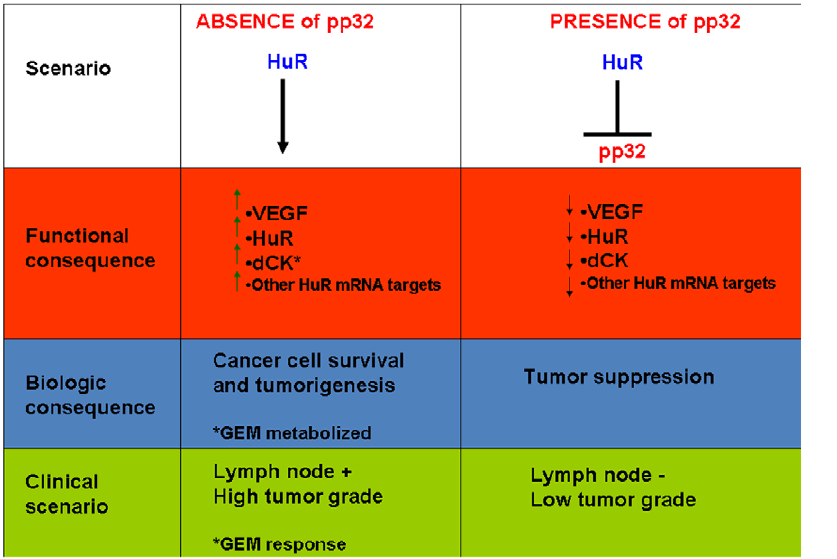
Figure 7. Schematic depiction of the functional, biologic, and clinical consequences of pp32 expression levels on HuR’s post- transcriptional regulation of targets including dCK, VEGF, and HuR mRNAs. On the left side shows a scenario where pp32 is reduced or absent (tumorigenesis) and HuR is available to associate and stabilize mRNAs that support cancer cell survival and viability. On the right side is a scenario in which pp32 is present (tumor suppression) and HuR can not bind to mRNAs important for cancer cell survival. Note: GEM is more likely to be metabolized from its prodrug form to its active metabolites by dCK in the scenario on the left. doi:10.1371/journal.pone.0015455.g007 PLoS ONE |